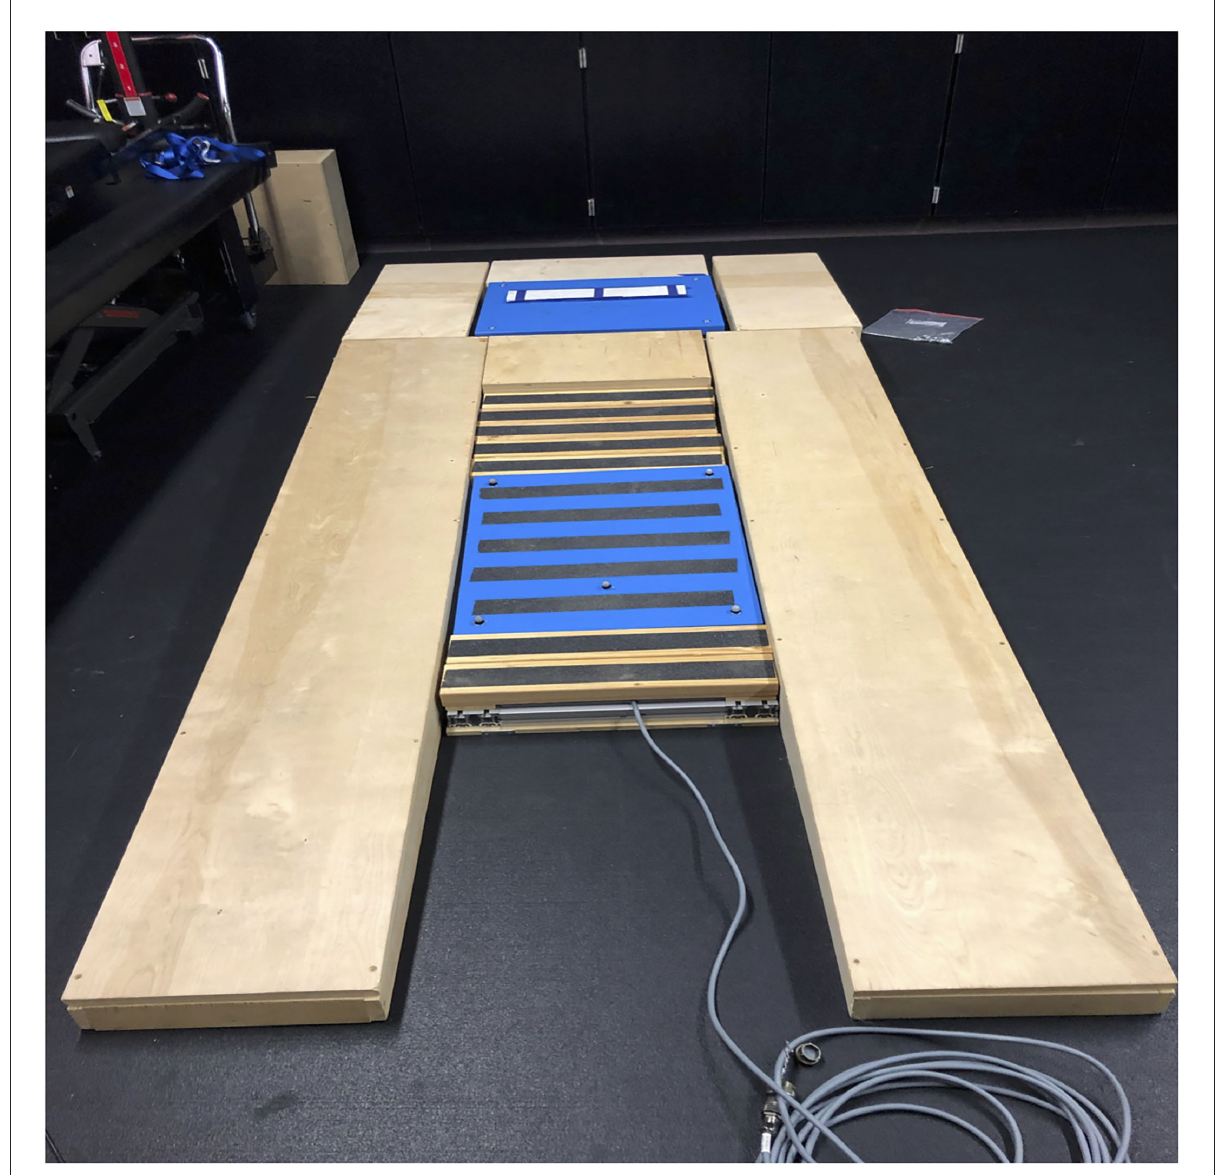
FIGURE2 Custom major league baseball regulation size pitching mound with two embedded force platforms.